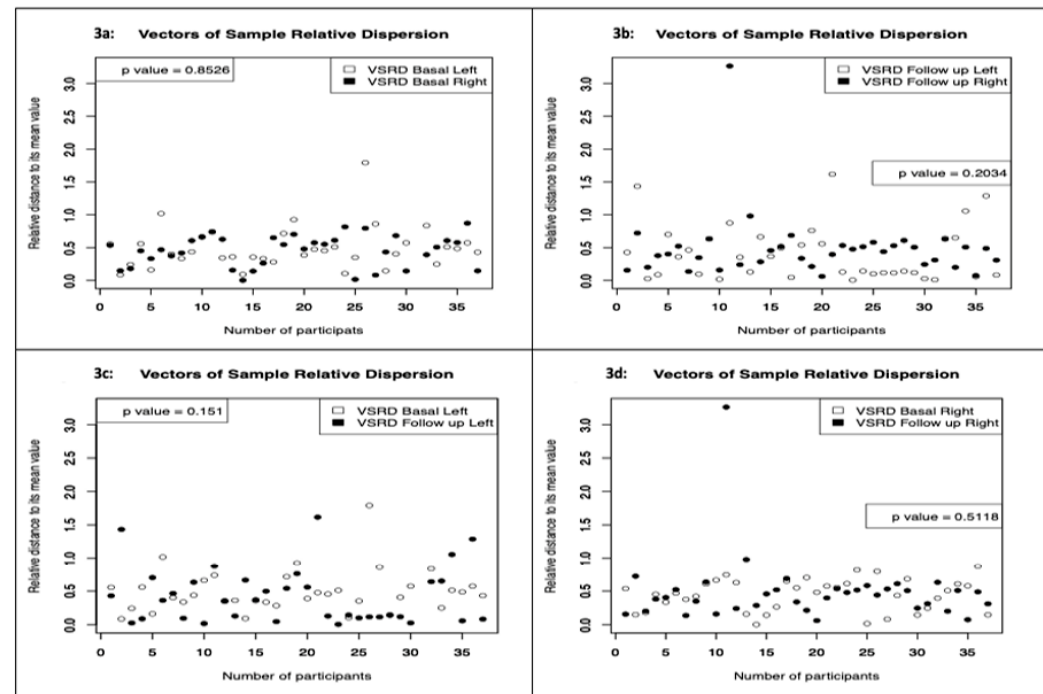
Figure 3. Vectors of Sample Relative Dispersion [VSRS], rather than the Vectors of Sample’s Squared Relative Dispersion [VSSRS] were graphed for a better conception of data dispersion. p -values were obtained comparing the Coefficient of Dispersions of each